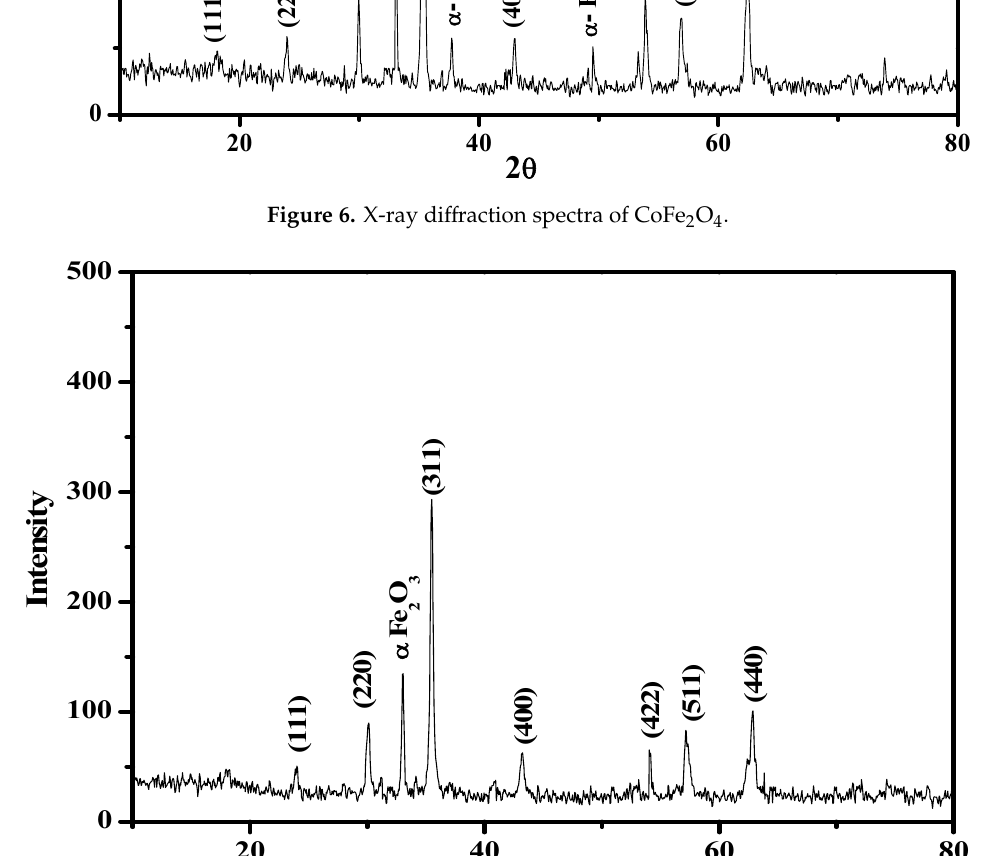
Figure 7. X ‐ ray diffraction spectra of Co 0.1 Al 0.03 Fe 0.17 O 0.4 . Figure 7. X-ray di ff raction spectra of Co 0.1 Al 0.03 Fe 0.17 O 0.4 Table 1. XRD results of CoFe 2 O 4 andCo 0.1 Al 0.03 Fe 0.17 O 0.4.